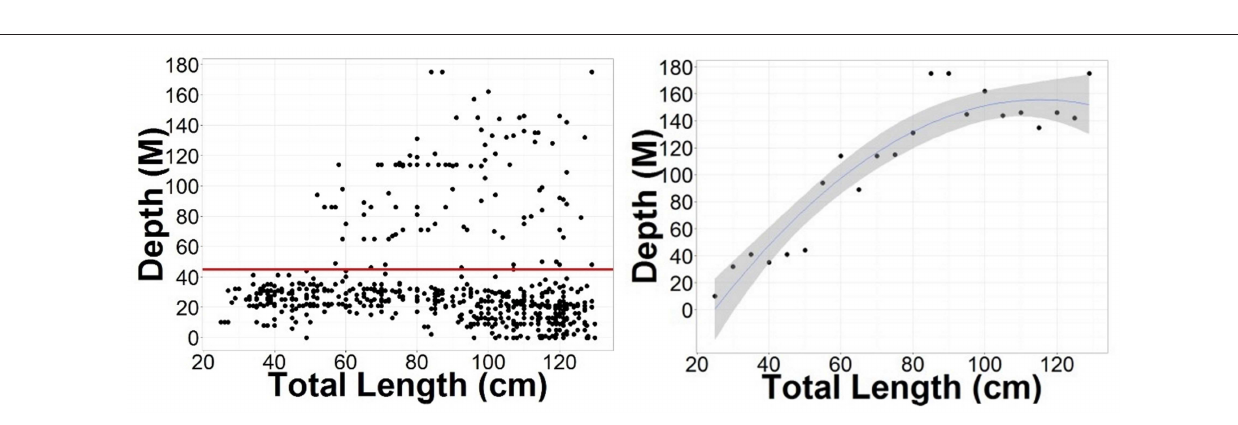
FIGURE 3 | (Left) Depth distributions compared to the length of tope recaptured in the northeast Atlantic from mark-recapture data sets, with a red line at 45m to signify the depth limitation of tope < 50cm long. (Right) Points show the maximum water depth reached by each 5cm length class. Blue line represents a polynomial linear model with depth as a function of Total Length. Adjusted R 2 = 0.8778, DF = 19, p = 8.186–10. Gray ribbon represents standard